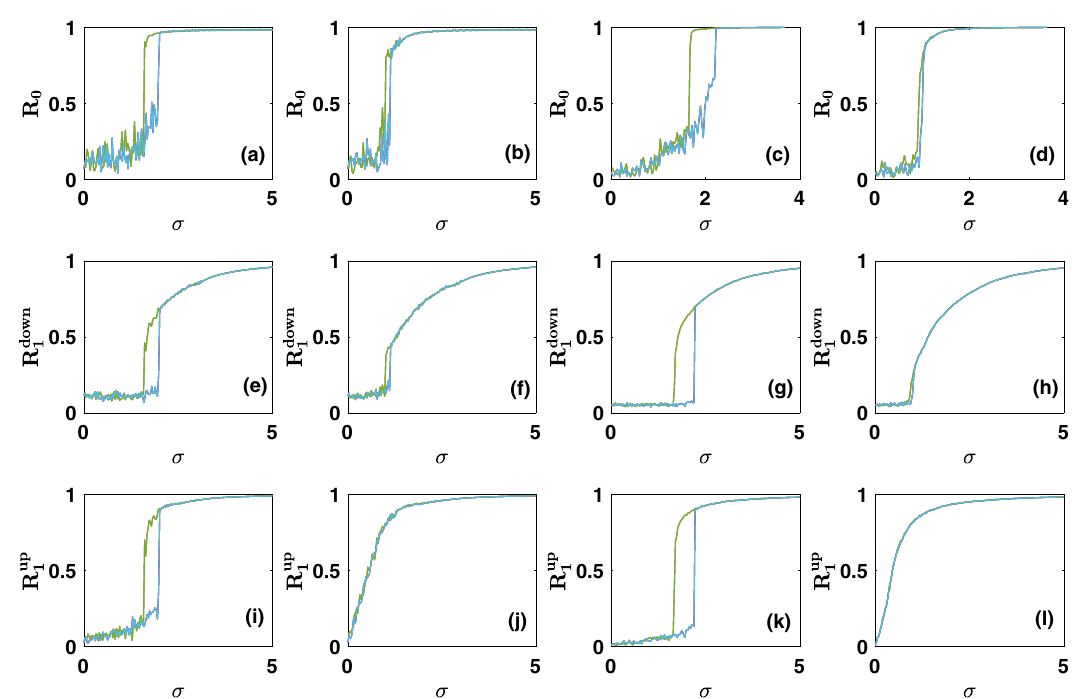
Fig. 3 The higher-order topological synchronization models coupling nodes and links on real connectomes. The hysteresis loop for the synchronization order parameters R 0 , R down , and R up are plotted versus σ on real connectomes. The green lines indicate the backward transitions and the cyan lines 1 1 indicate the forward transitions. Panels a , e , i and b , f , j show the numerical results on the human connectome 52 for Model Nodes-Links-Triangles (NLT) and Model Nodes-Links (NL) respectively. Panels c , g , k and d , h , l show the numerical results on the C. elegans connectome 53 for Model NLT and Model NL, respectively. In both Model NLT and in Model NL we have set Ω 0 = Ω 1 = 2 and τ 0 = τ 1 =